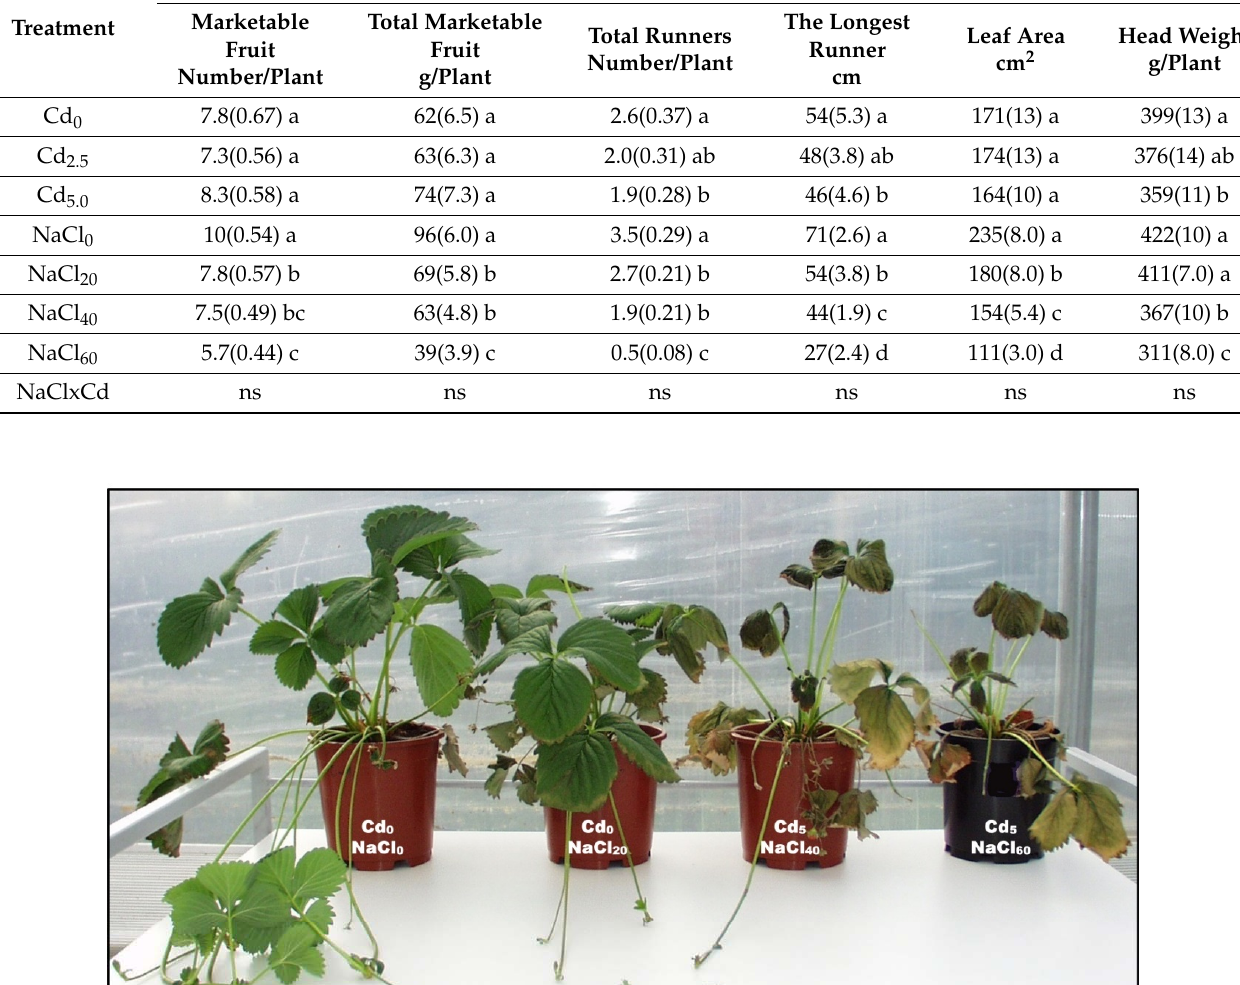
Table 1. Impact of applied treatments on vegetative growth and yield parameters of test plant species 70 days (strawberry) and 30 days after salinity treatment commenced (lettuce). Means (standard errors in parenthesis; n = 4) with the same letter in a column for a given main effect are not significantly different, according to the Tukey’s HSD test.